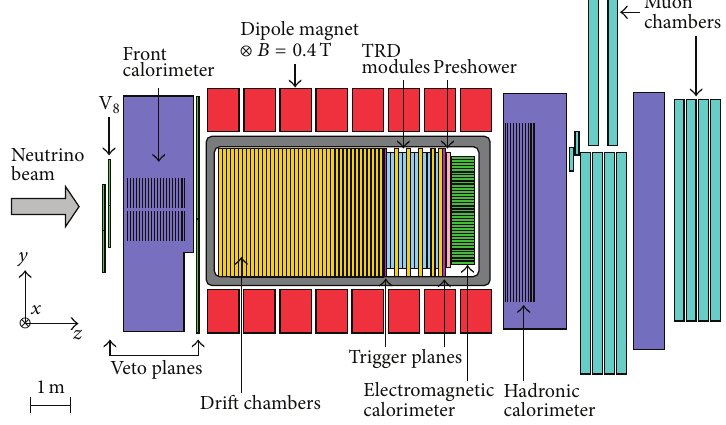
Figure 2: A schematic sideview of the